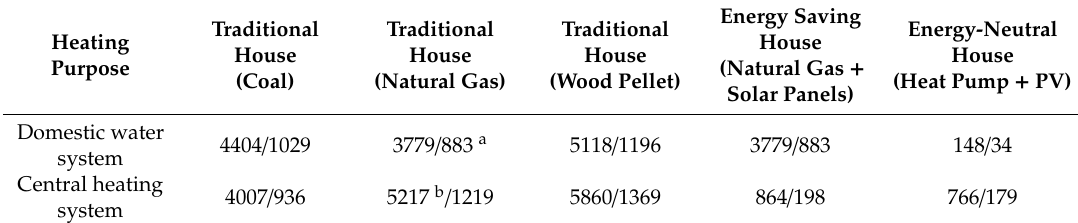
Table 3. Energy generation costs for domestic water and central heating systems for homes built using alternative technologies and using di ff erent energy sources scenarios in PLN and